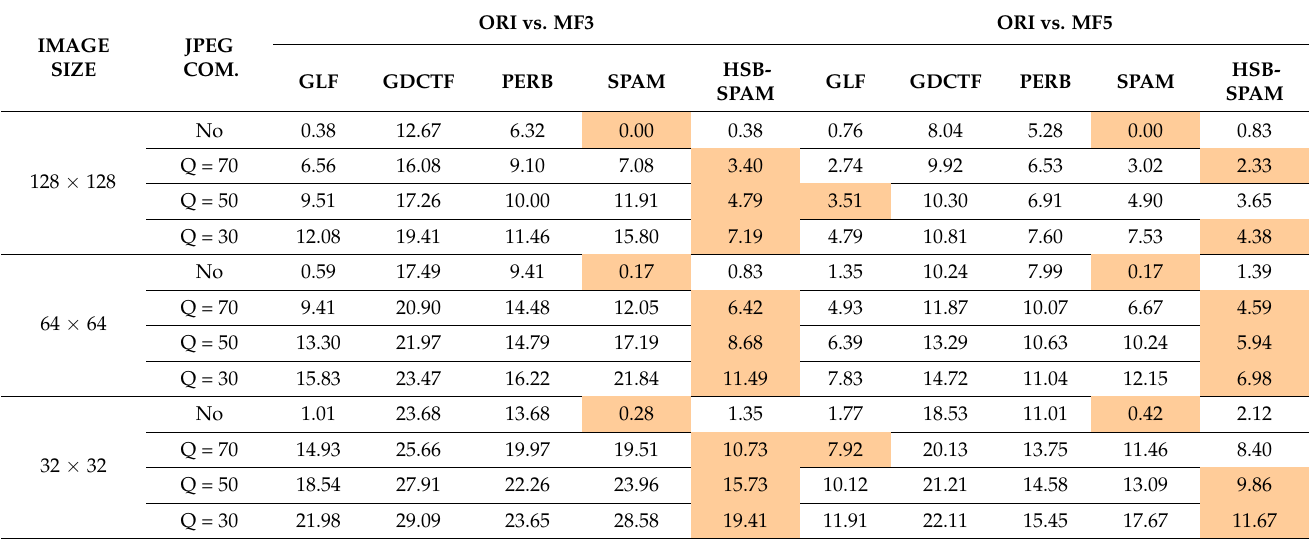
Table 1. Percentage of detection error onMF3 and MF5